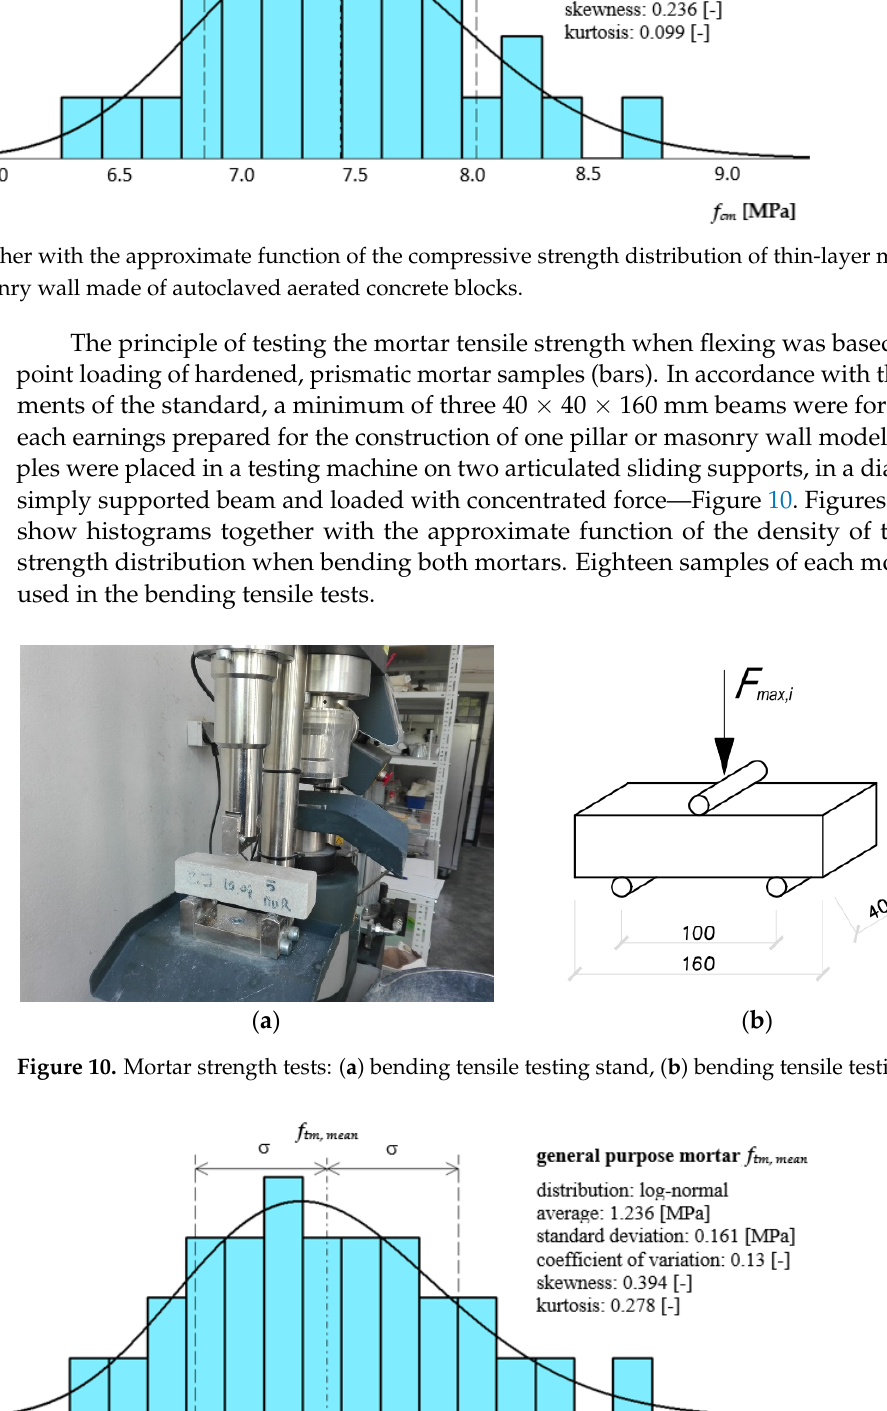
Figure 8. Histogram together with the approximate function of the compression strength distribution of general purpose mortar as a component of a clay brick masonry pillar.